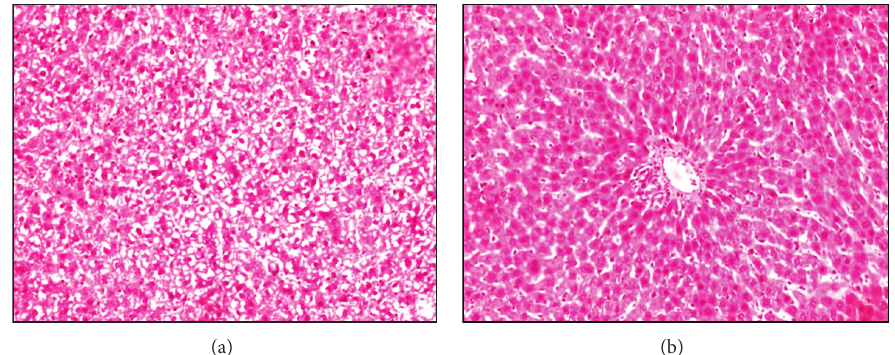
Figure 1: Histological microimages of liver tissues from (a) rat model of acute liver failure and (b) healthy control rat stained with H&E. Magnification: ×